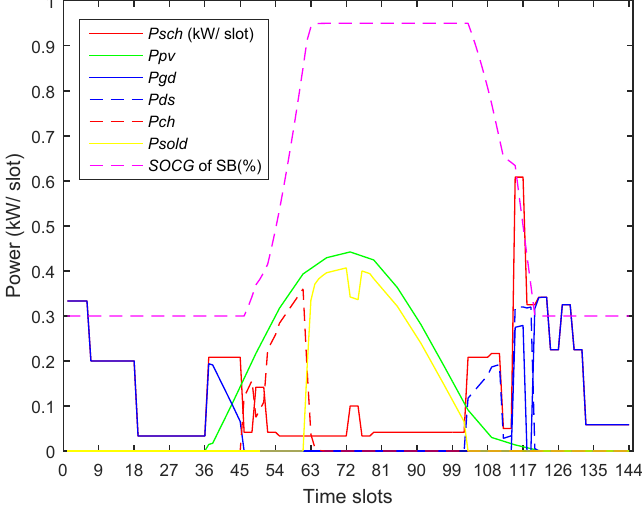
Figure 30. Load profile for minimal TBD using DA-RTP (Non-shifted) for PDDR-RED-based